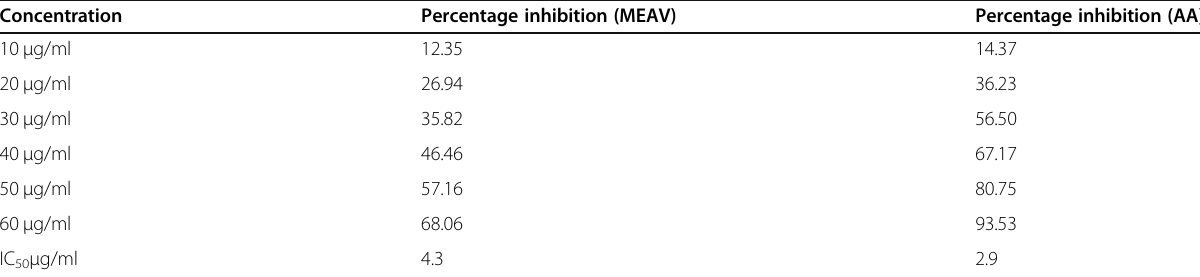
Table 2 Percentage inhibition of methanol extract of A. vulgaris leaves and standard (ascorbic acid) Concentration Percentage inhibition